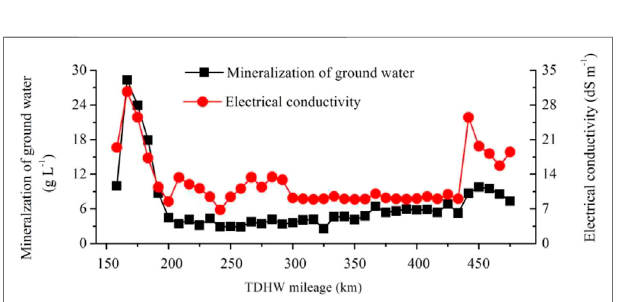
FIGURE 4 | Spatial distributions of groundwater mineralization and electrical conductivity in the salt crust along the desert highway, reproduced from Li et al. (2012).